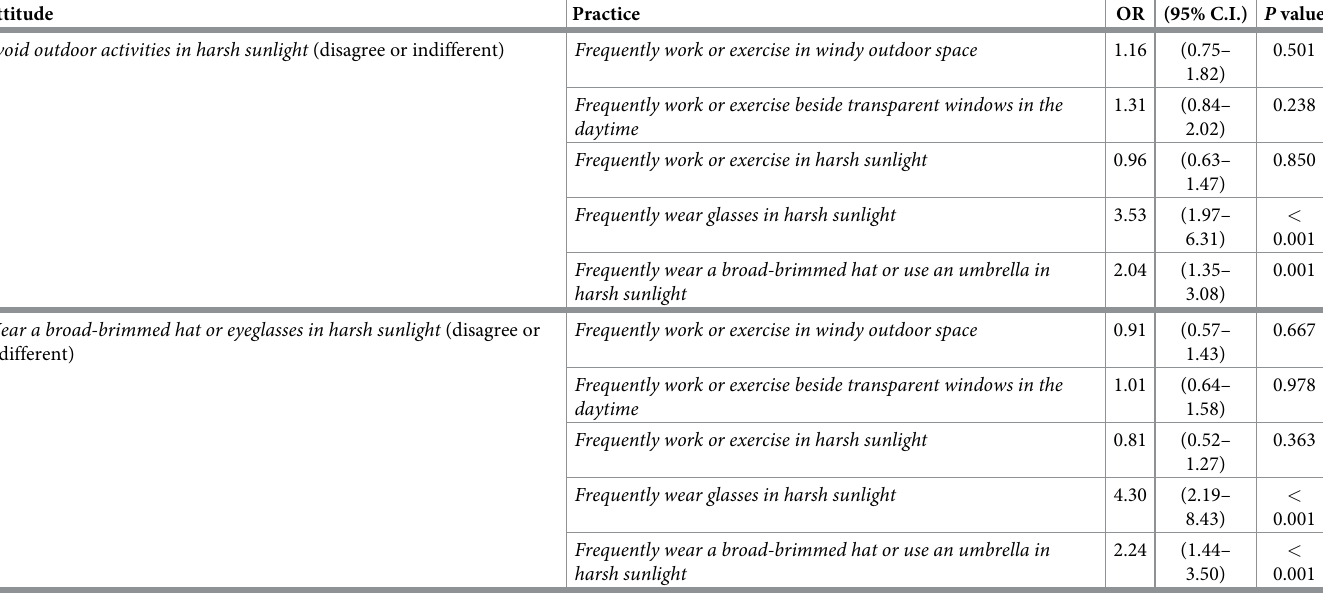
Table 3. Relationship between attitudes and practices of eye protection under sun exposure. Attitude